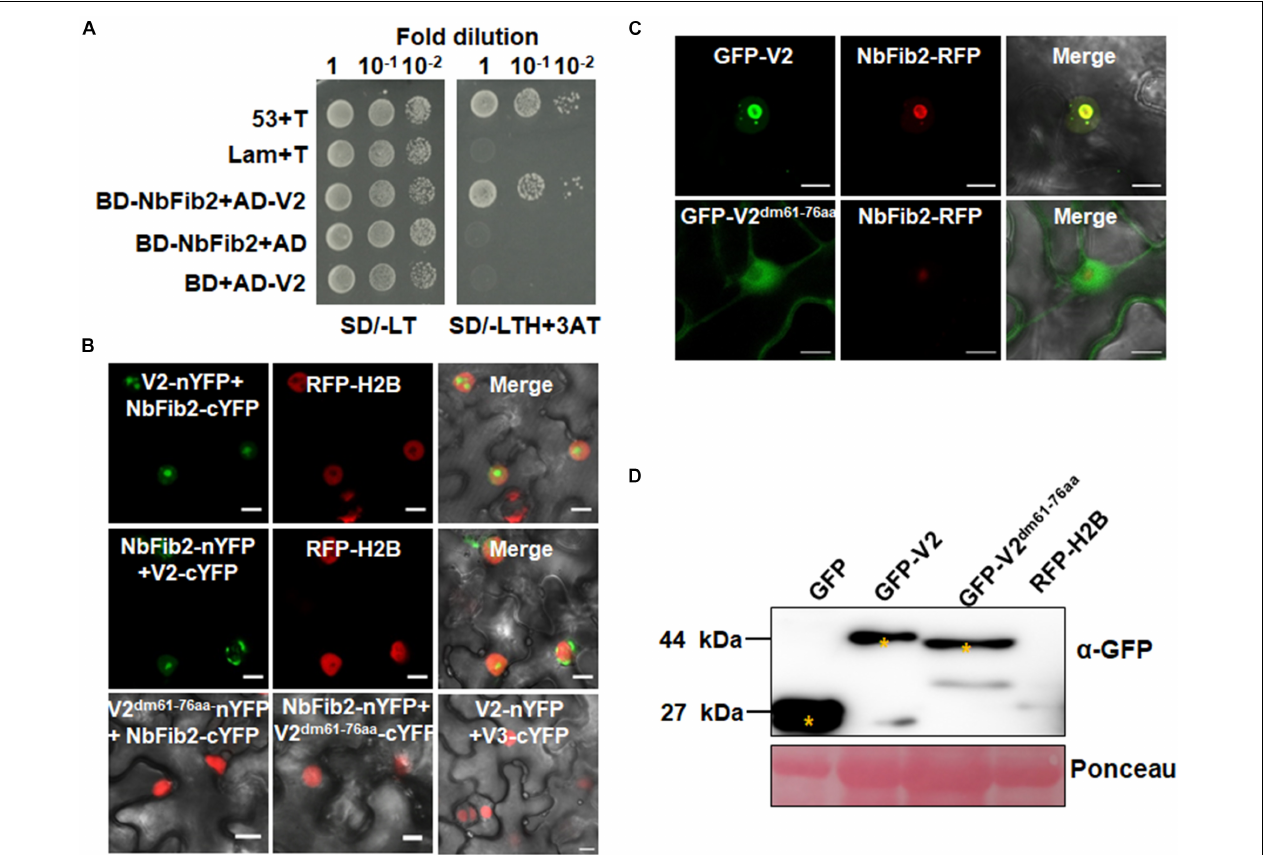
FIGURE 2 | V2 interacts with NbFib2. (A) Yeast two-hybrid assay showing the interaction between V2 and NbFib2 in yeast cells. Full-length NbFib2 was expressed as GAL4 DNA-binding domain fusion (BD, bait) and V2 was expressed as GAL4 activation domain fusion (AD, prey) in yeast cells of the strain Y2H Gold. The interaction of p53 and T was used as a positive control, and cotransformation of Lam and T was used as a negative control. Growth on the plates lacking leucine and tryptophan (SD/-LT) indicates successful transformation of both prey and bait vectors, respectively. Interaction between NbFib2 and V2 is indicated by growth of yeast cells on media also lacking histidine supplementing with 5 mM 3-amino-1,2,4-triazole (SD/-LTH + 3-AT). (B) Bimolecular fluorescence complementation assay (BiFC) assay showing the interaction between NbFib2 and V2 in plant cells. Constructs containing N-terminal YFP fusion (nYFP) and C-terminal YFP fusion (cYFP) fusions were infiltrated into RFP-H2B plant leaves. Combinations of BiFC constructs are shown at the top of each panel. Images were taken using a Zeiss LSM 880 confocal laser scanning microscope at 48 hpi. Reconstituted YFP signals resulting from V2-NbFib2 interaction are displayed as a false-green color. RFP-H2B served as a nuclear marker. Note that deletion of the predicted nuclear localization signal (from amino acid 61–76) of V2 abolishes its interaction with NbFib2. (C) Colocalization analysis of NbFib2 with V2 and V2 mutant in the epidermal cells of N. benthamiana by Zeiss LSM 880 confocal laser scanning microscope at 36 hpi. At least 60 cells from three repeats were examined. Scale bars correspond to 10 µ m. (D) Immunoblot of proteins from RFP-H2B plant leaves infiltrated with construct as indicated using anti-GFP antibody. Ponceau staining of the large subunit of Rubisco serves as a loading